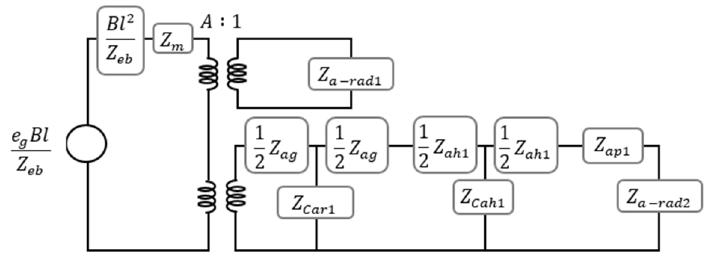
Figure 2. Microspeaker equivalent circuit diagram.